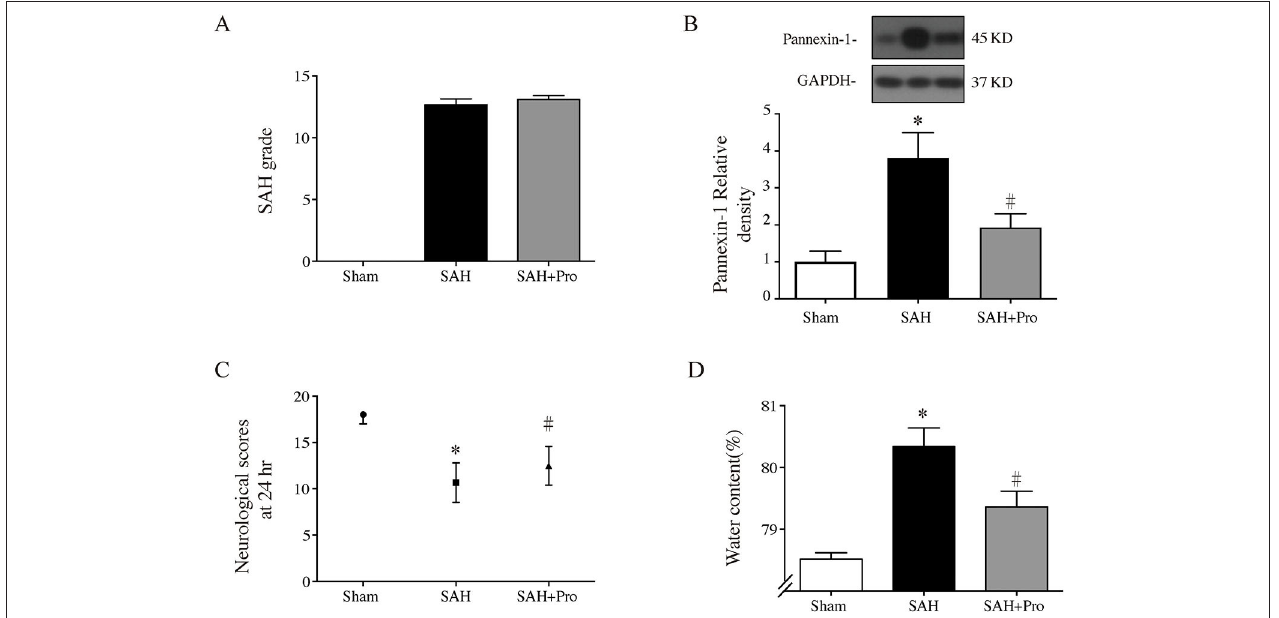
FIGURE 2 | (A) The quantification of SAH severity, n = 21 for each group. (B) Pannexin-1 protein levels in sham, SAH, and SAH + pro groups, n = 6 each group. * p < 0.05 vs. sham group, # p < 0.05 vs. SAH group. (C) The quantification of neurological scores. Values are median (interquartile range), n = 21 each group, * p < 0.05 vs. sham group, # p < 0.05 vs. SAH group. (D) Brain water content measured by the wet–dry method, n = 6 each group. * p < 0.05 vs. sham group, # p < 0.05 vs. SAH